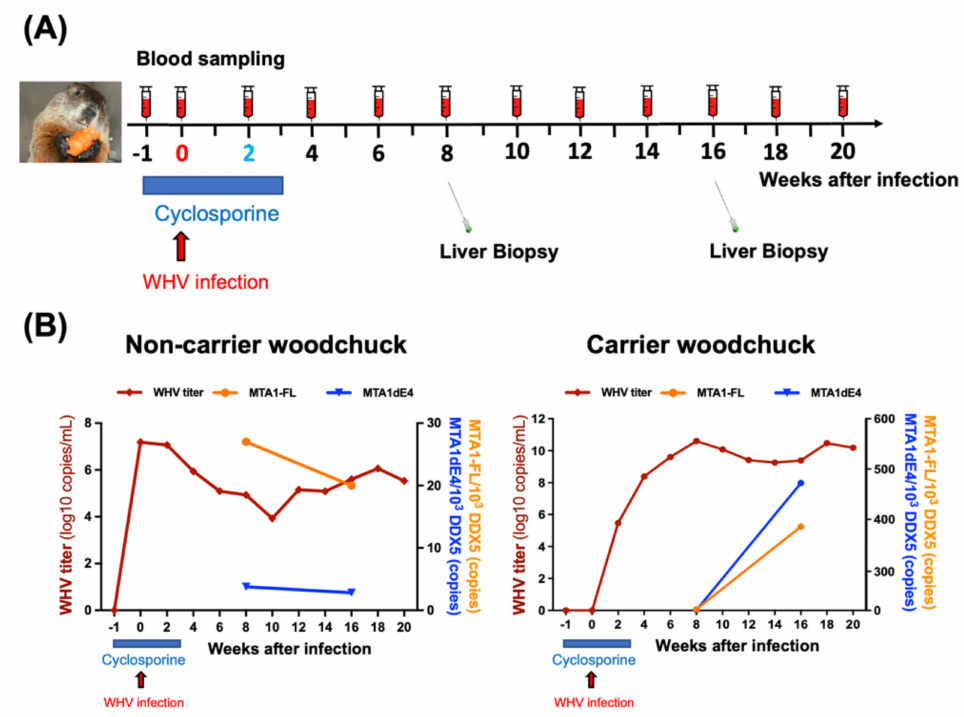
Figure 4. Both MTA1-FL and MTA1dE4 were significantly increased in the liver of woodchuck after WHV infection. ( A ) A schematic illustration of the experimental procedure. To increase the possibility of chronic infection, the woodchucks were treated with cyclosporin to inhibit immune response a